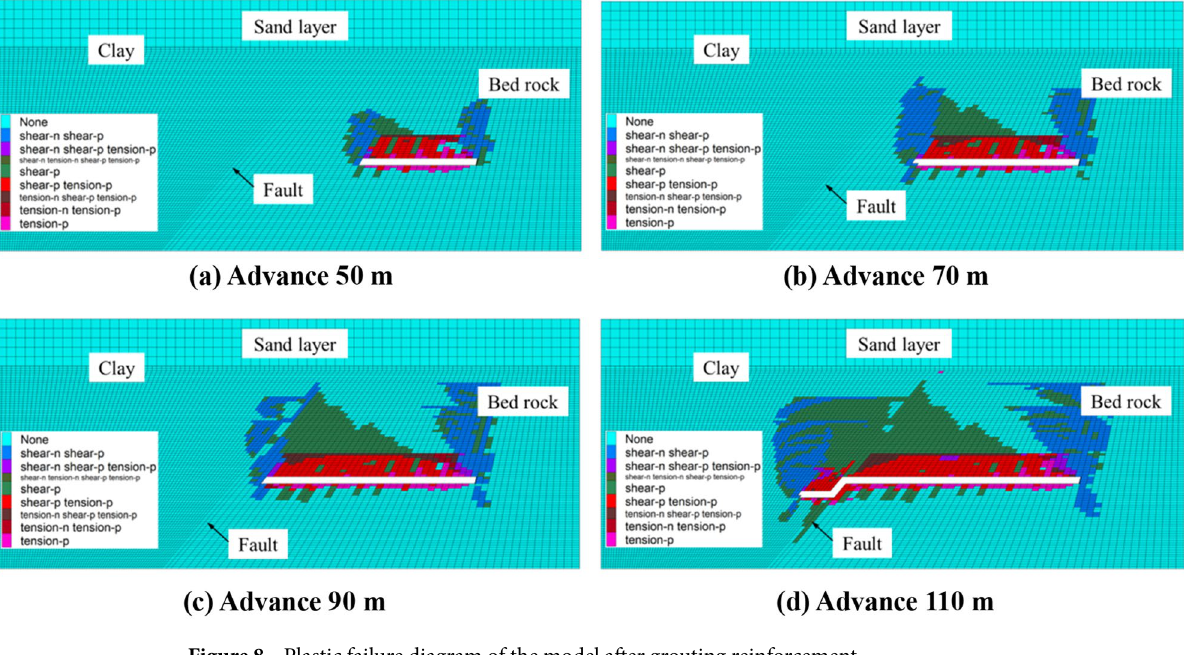
Figure 8. Plastic failure diagram of the model after grouting reinforcement.